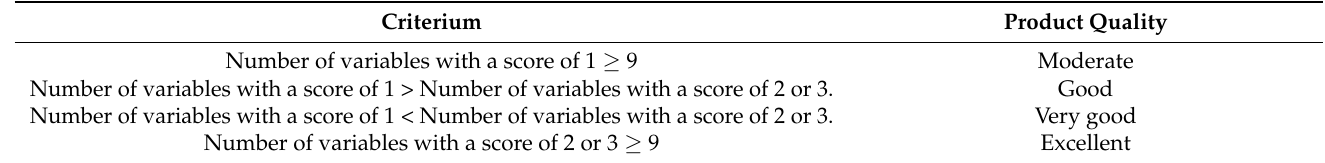
Table 4. Quality classification criteria of the “Chorizo Zamorano”